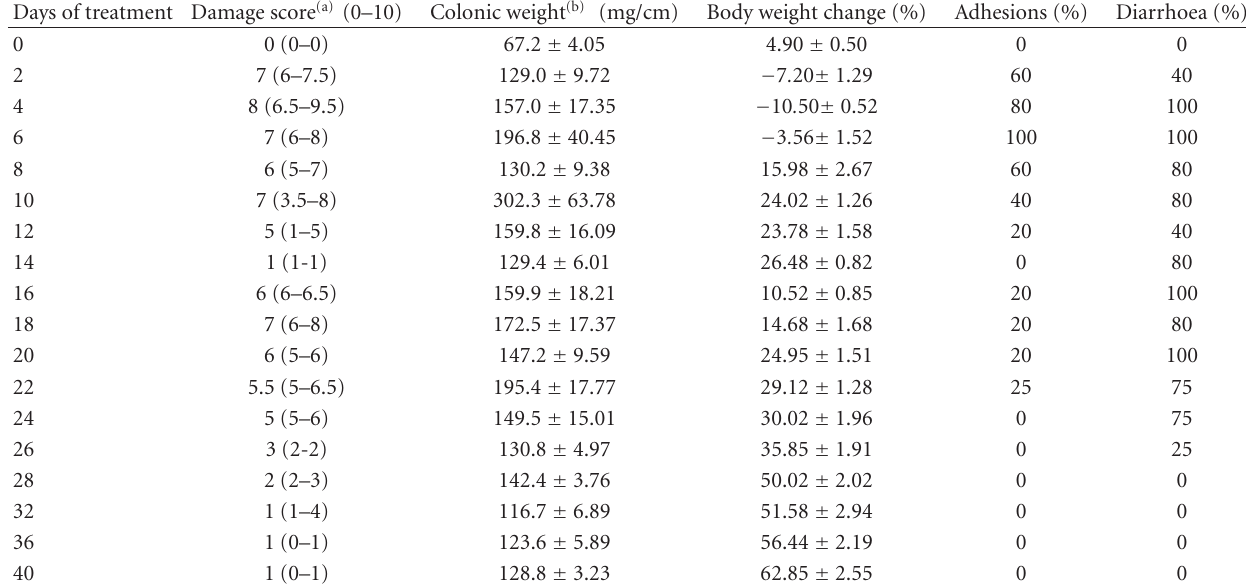
Table 2: Damage score, changes in colonic weight, changes in body weight and incidence of adhesions and diarrhoea of colitic rats with relapse induced by TNBS.